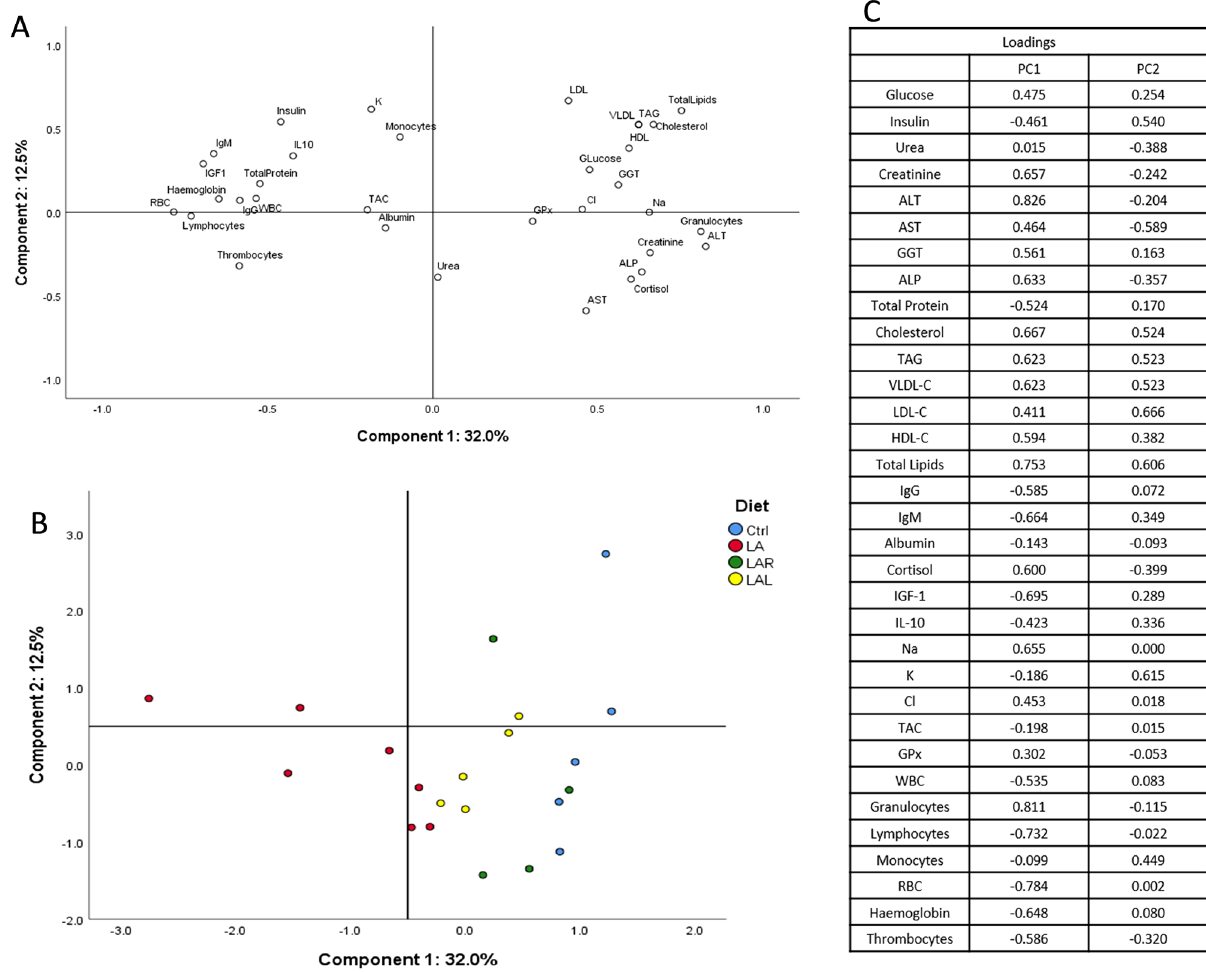
Figure 1. Principal component analysis (PCA) of serum profile ( A ) and distribution of experimental groups on components 1 and 2 ( B ) from piglets fed Ctrl—control diet; LA—control + 10% Laminaria digitata ;